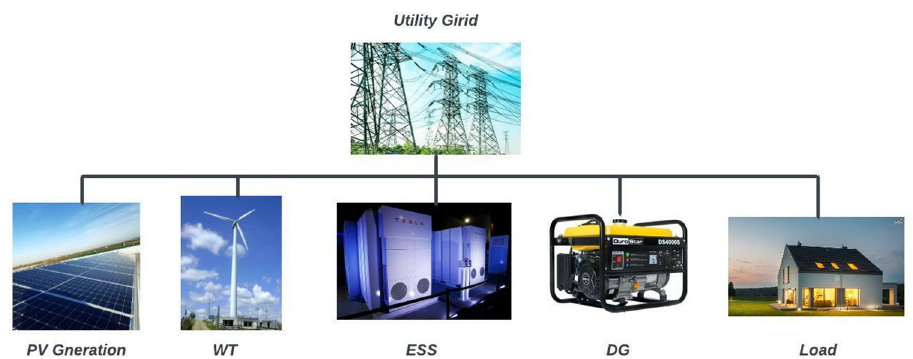
Figure 1. Microgrid architecture, which consists of DERs including RESs (PV and WT), DG, and the battery ESS, and loads. The MG can be disconnected from the utility grid and work in autonomous mode, where DERs supply the local load and the BESS holds the consumption–production balance.